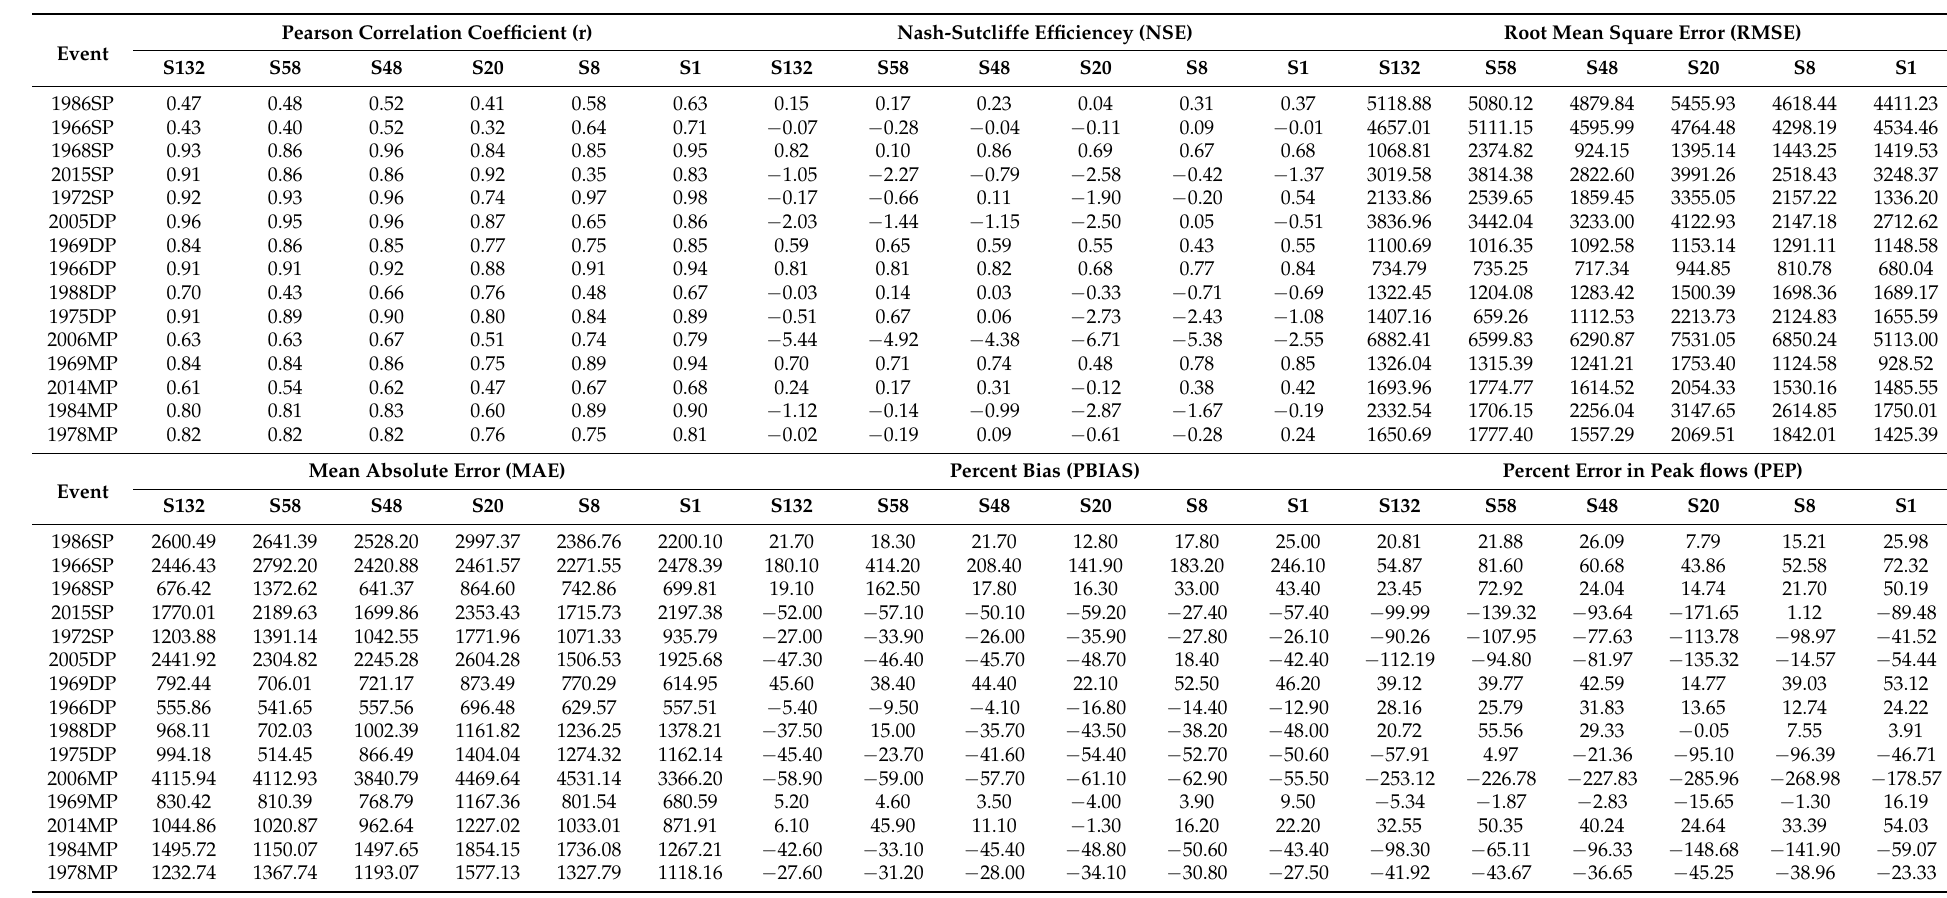
Table A1. Verification metrics for streamflow simulations of the reference scenario; verification metrics from left to right column are r, NSE, RMSE, MAE, PBIAS and PEP for six configurations, and each row corresponds to an